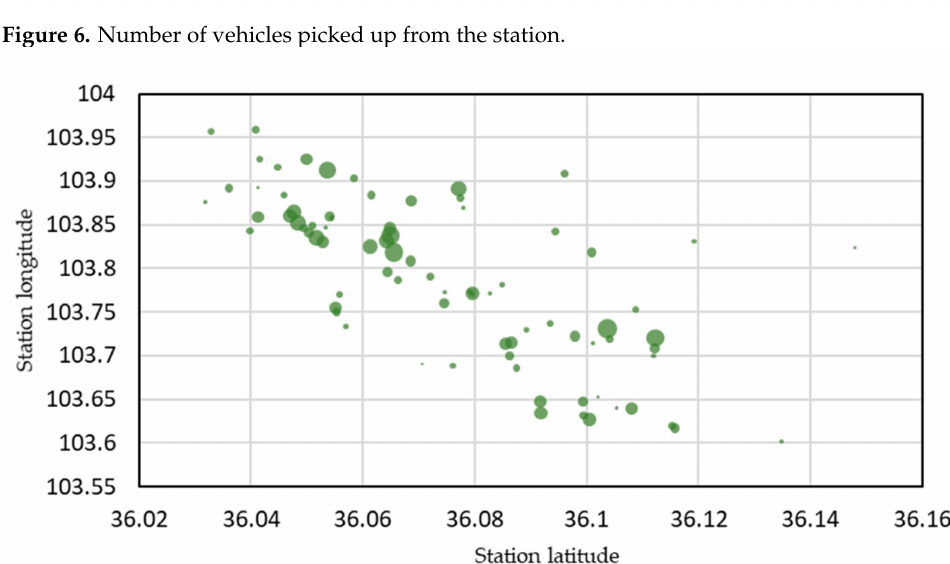
Figure 6. Number of vehicles picked up from the station.